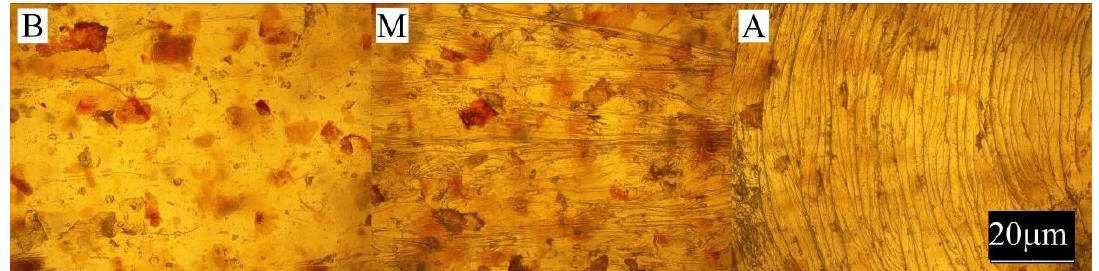
Figure 6. Appearance of the individual parts of the injection moulding obtained with a 5% content of bran fraction with grain size <0.4 mm at measuring points A, M, B (the positions of the points are marked in Figure 1). Materials 2020 , 13 , x FOR PEER REVIEW